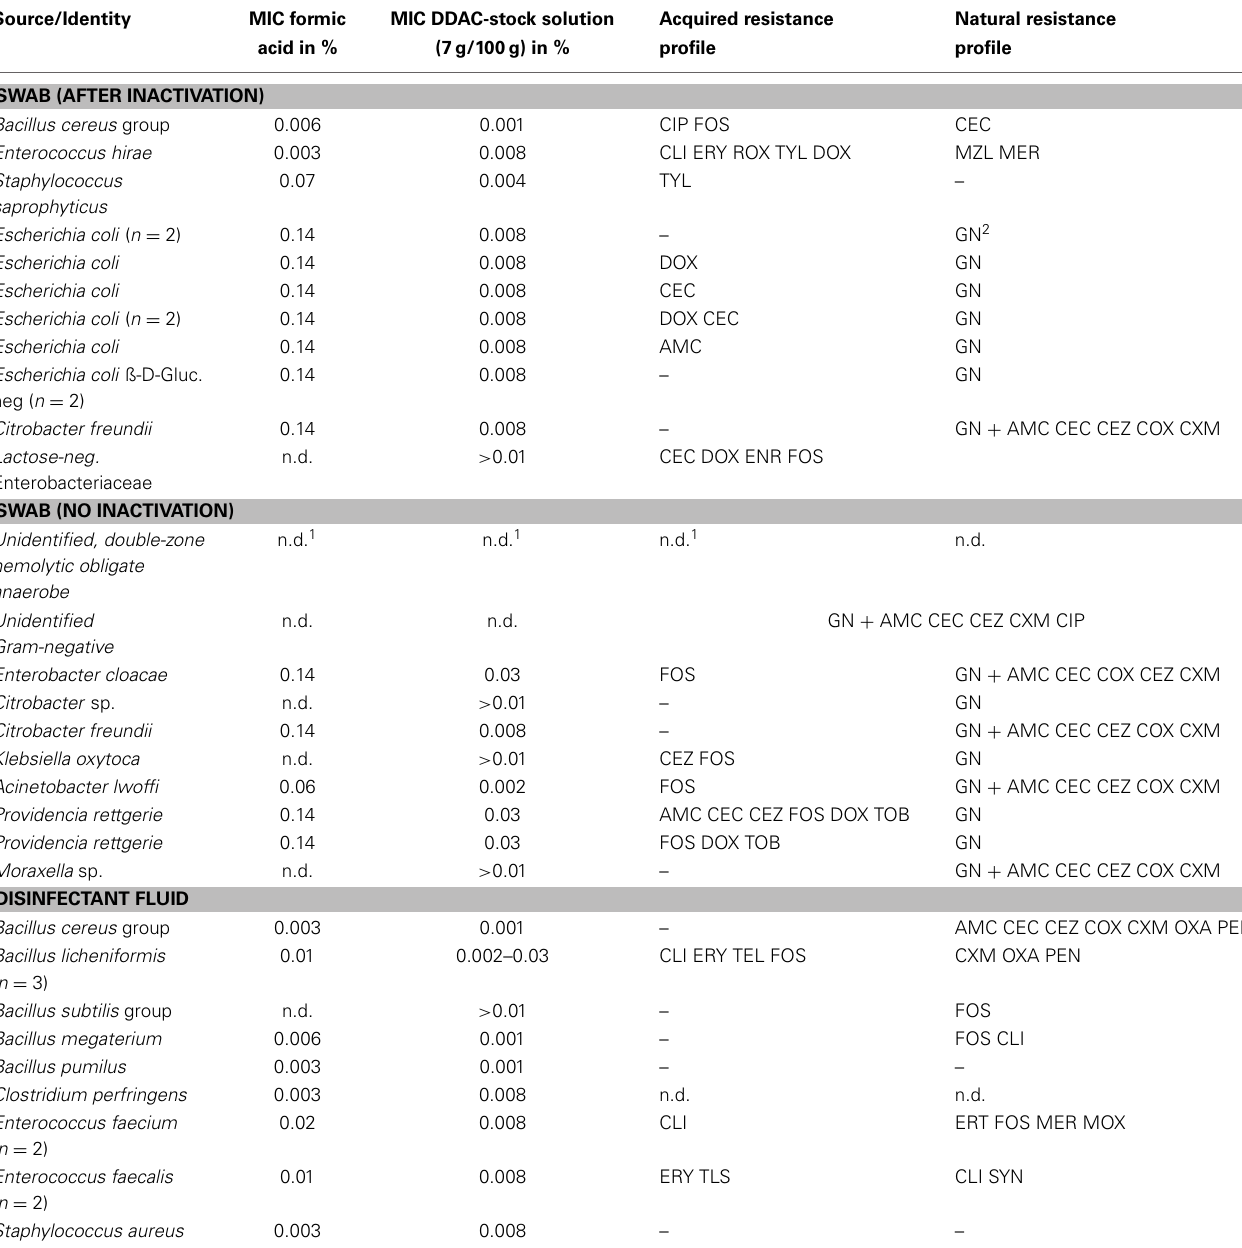
Table 5 | Antimicrobial resistance and susceptibility to disinfectants of bacteria isolated from boot bath disinfectant (2% concentrate = 1.1% formic